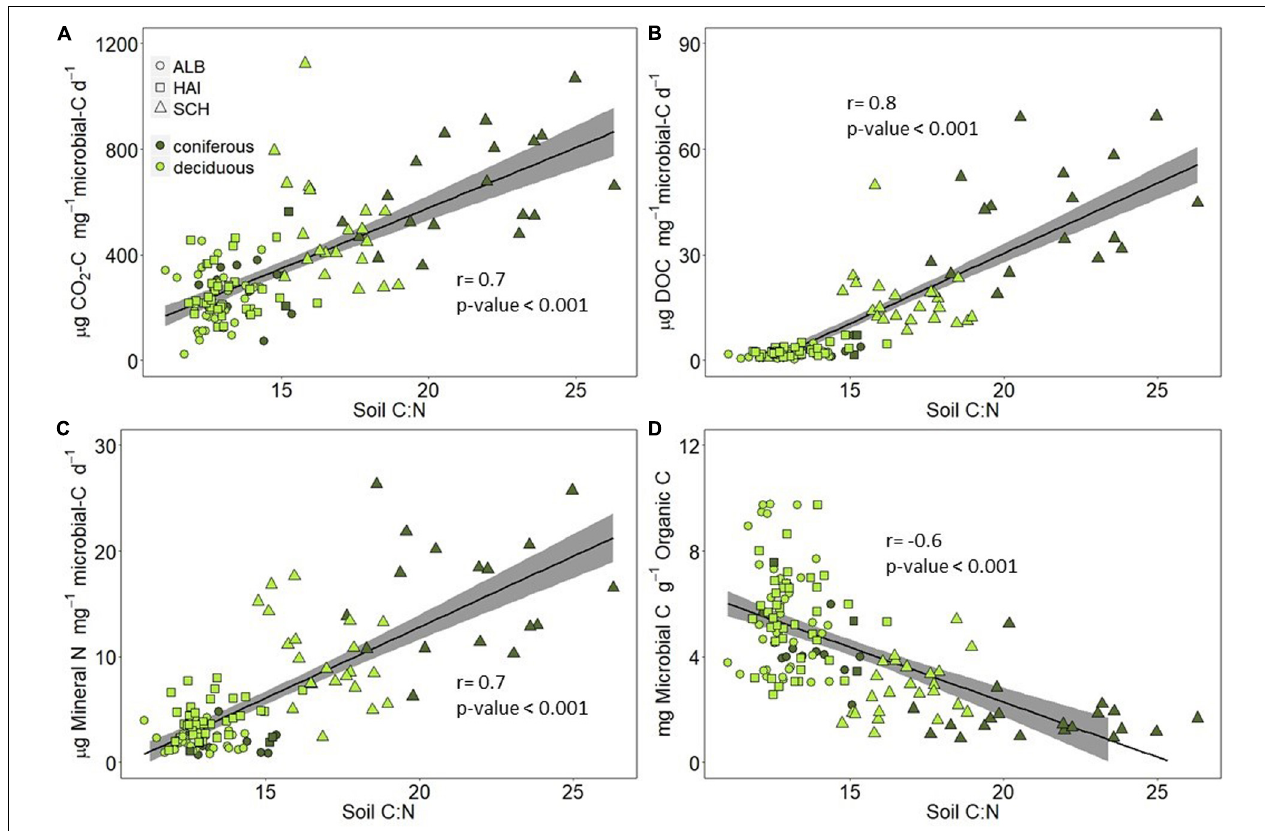
FIGURE 7 | Correlations between (A) C mineralization per microbial C, (B) DOC leached per microbial C, (C) N mineralization per microbial C, and (D) microbial C per organic C and soil C:N ratio. Study regions are denoted by: ALB, Schwäbische-Alb; HAI, Hainich-Dün; SCH,